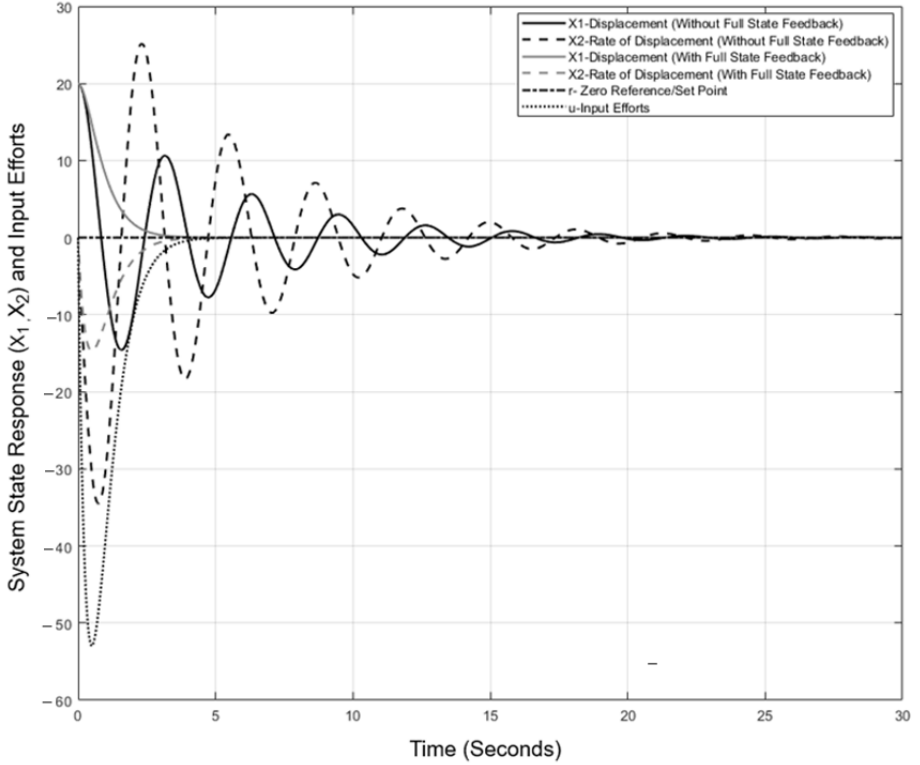
Figure 20. System state response with and without full state feedback (closed-loop control) for a zero reference/set point (equilibrium state) and [20 0] initial condition (Case example 1).